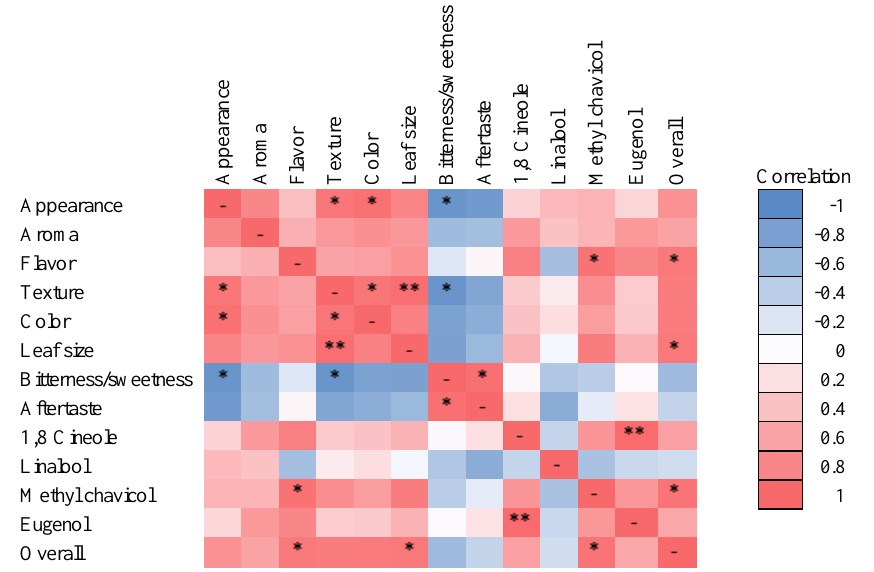
Figure 4. Sensory preference and volatile organic compound correlation. Heat map illustrating the correlation between volatile organic compounds (VOCs) and sensory preference characteristics of sweet basil ( Ocimum basilicum ‘Nufar’ ) grown at mean daily temperatures (MDT) from 23 to 36 °C for three weeks. Blue and red represent negative and positive correlations, respectively. Asterisks indicate significant correlations based on Pearson’s correlation *, p < 0.05; **, p < 0.01.